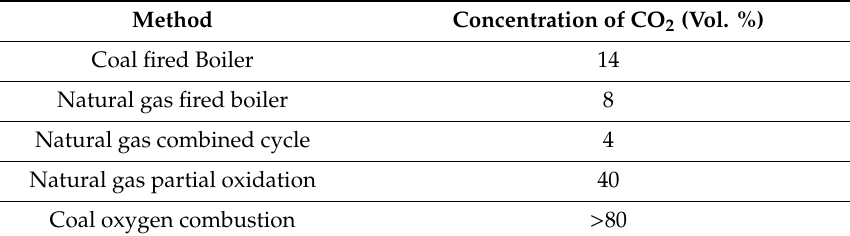
Table 2. Amount of CO 2 in flue gases of power plants [31].